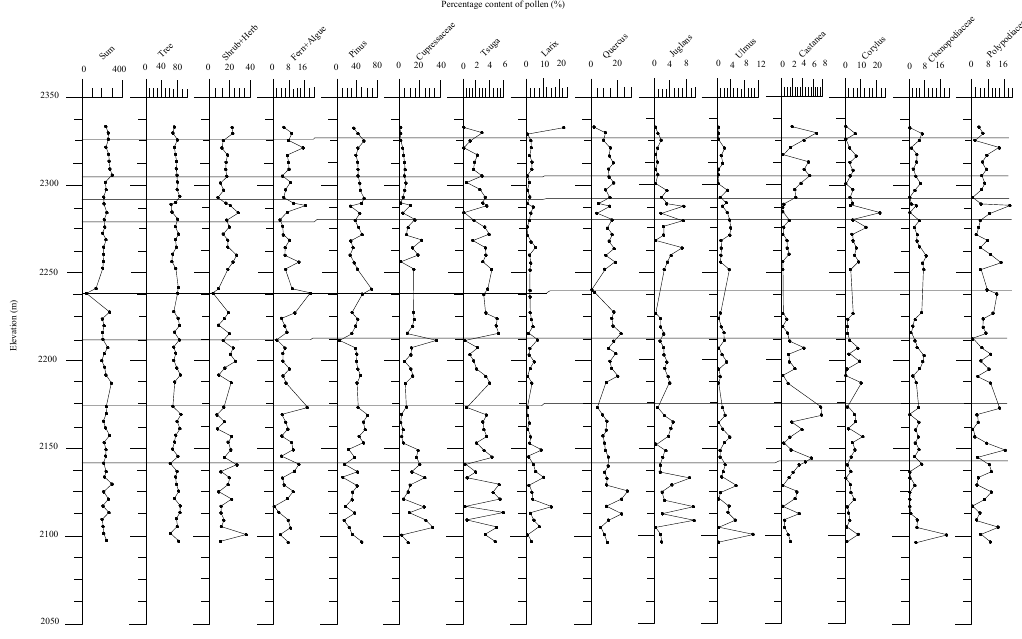
Figure 5. Pollen and spore schema with elevation. Fig. 5. Pollen and spore schema along the elevation